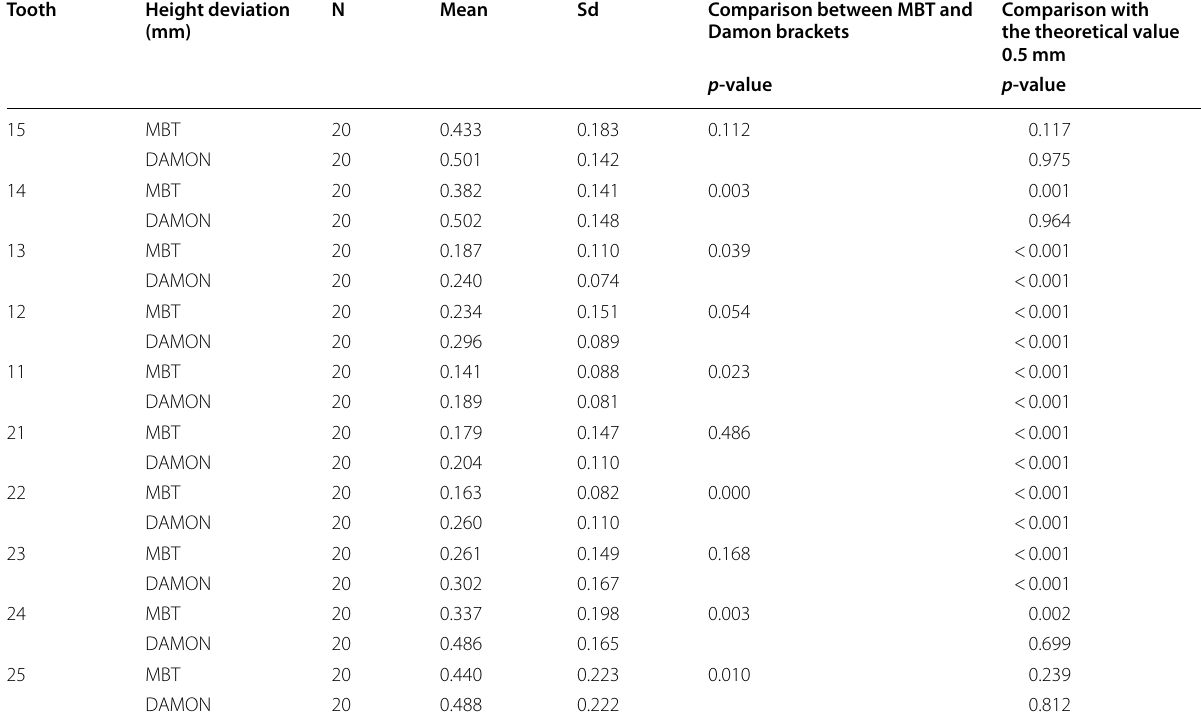
Table 2 Mean and standard deviation of the differences in height between direct and indirect methods using MBT and Damon